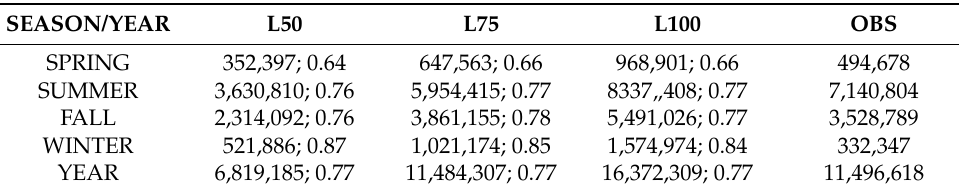
Table 2. Number of strokes simulated with the different charge transfer settings by the DLS (columns L50, L75, and L100) and observed by LINET (column OBS) for each season and for the whole year. The second number in each cell of the L50, L75, and L100 columns shows the correlation coefficient for the daily simulated and observed number of strokes for each season and for the whole year. The number of pairs used for each correlation are those from Table 1: 29 in spring, 69 in summer, 46 in fall, 19 in winter, 162 for the whole year.